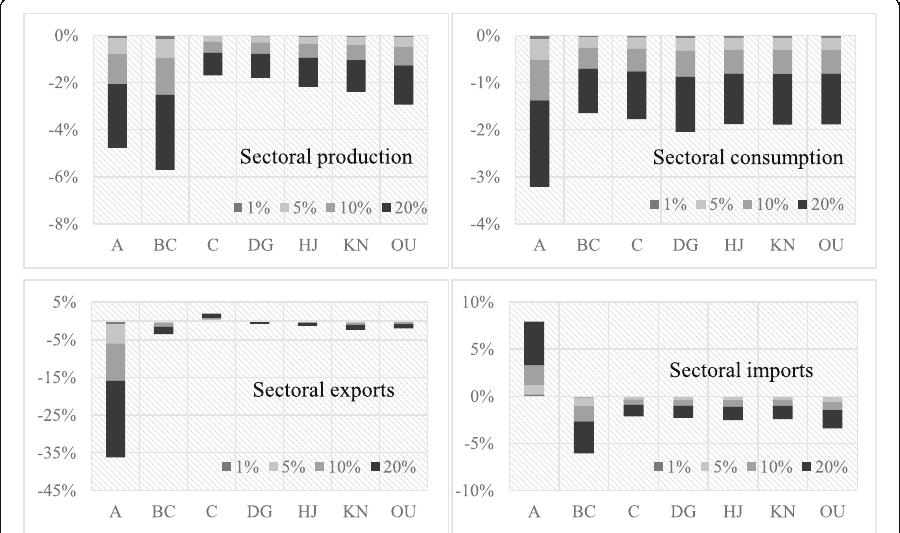
Fig. 15 Simulated sectoral effects of quantitative requests to increase the land use in agricultural production. (Source: authors calculations based on CGE model simulations